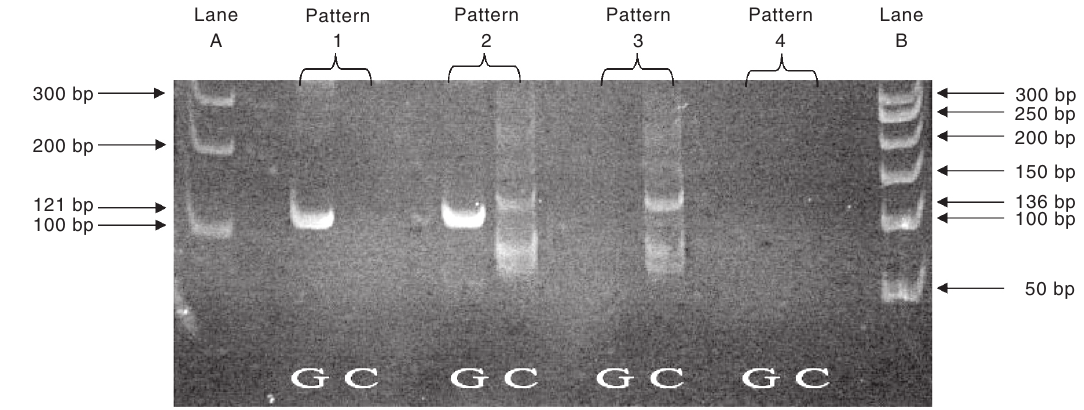
Figure 1. PCR products of IL-6 promoter polymorphism (-174 G/C) were shown by ethidium bromide-stained 18% polyacrylamide gels run at 140 V for 2 h. Lane A, 100-bp DNA marker (Fermentas Life Sciences, USA). Pattern 1: Homozygous G (121 bp). Pattern 2: Heterozygous G/C (121 and 136 bp). Pattern 3: Homozygous C (136 bp). Pattern 4: DNA blank. Lane B, 50-bp DNA marker (Fermentas Life Sciences,